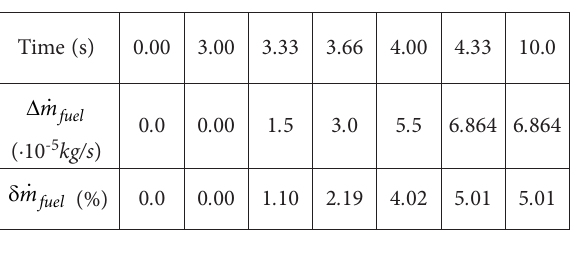
Table 4. Measured fuel flow change used for simulated